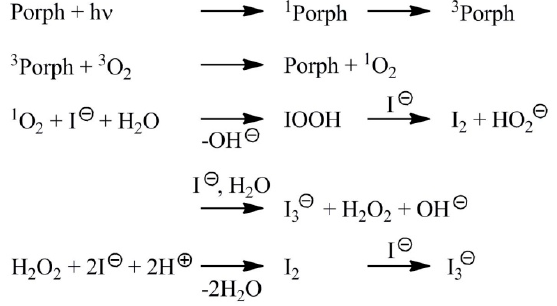
Table 7. Lifetimes of the excited triplet states of the different porphyrins under different conditions.